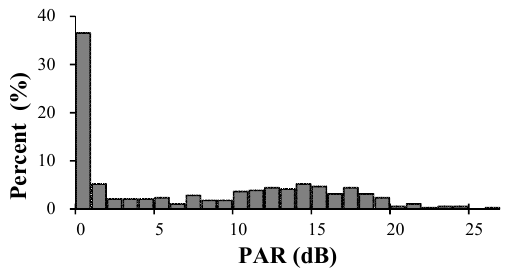
Figure 2. Histogram showing the distribution of personal attenuation ratings (PARs) achieved by percentage of the noise-exposed workers ( n = 385) in this study. The Pearson correlation between PAR and L Aeq,8h is − 0.032 ( p = 0.394). This indicates a slight negative linear relationship between PAR and L Aeq,8h , but it did not reach signifi- cance. Analysis of variance (ANOVA) testing shows that there was no difference in the mean PAR among L Aeq.8h groups (F = 0.657, p = 0.709), as shown in Figure 3. Male workers achieved higher attenuation than female workers (F = 4.342, p = 0.038).